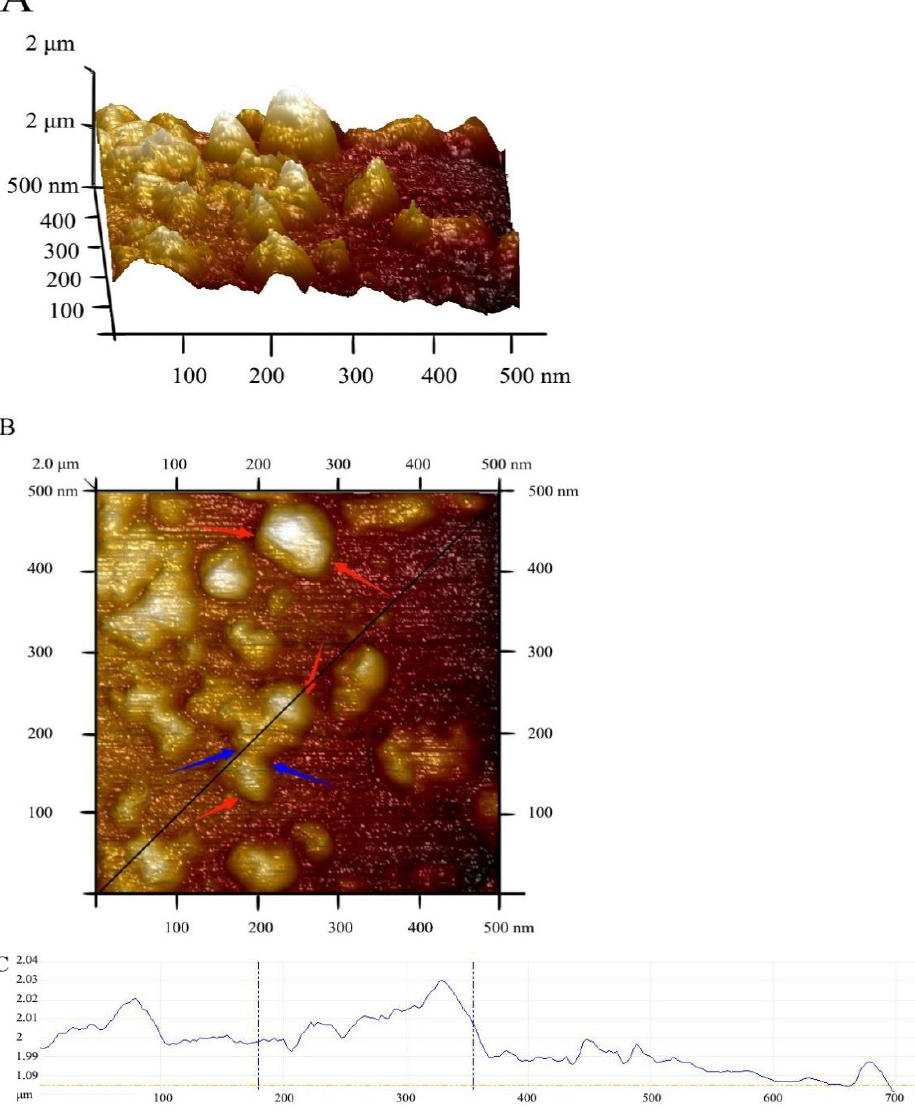
Figure 17. Surface topography of CpCR-SpyCatcher-SpyTag-GDH by AFM. ( A ) Side view by AFM. ( B ) Top view by AFM. ( C ) The cross-sectional analysis image. The red arrows indicate the boundaries of CpCR-SpyCatcher-SpyTag-GDH, the blue arrows indicate the intersecting and overlapping positions, and the uplift is formed by the aggregation and accumulation of CpCR-SpyCatcher-SpyTag-GDH.